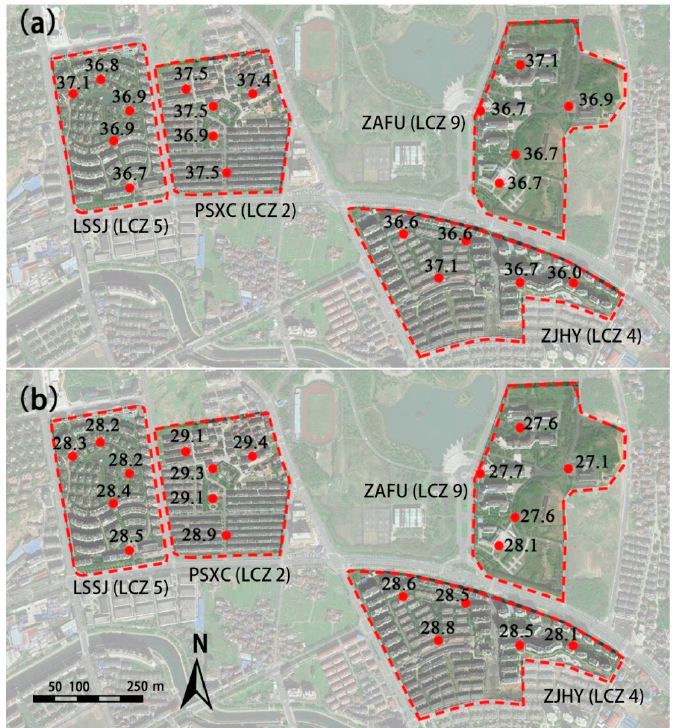
Figure 3. The mean air temperature ( °C ) in each LCZ at different times : ( a ) daytime, ( b ) nighttime.